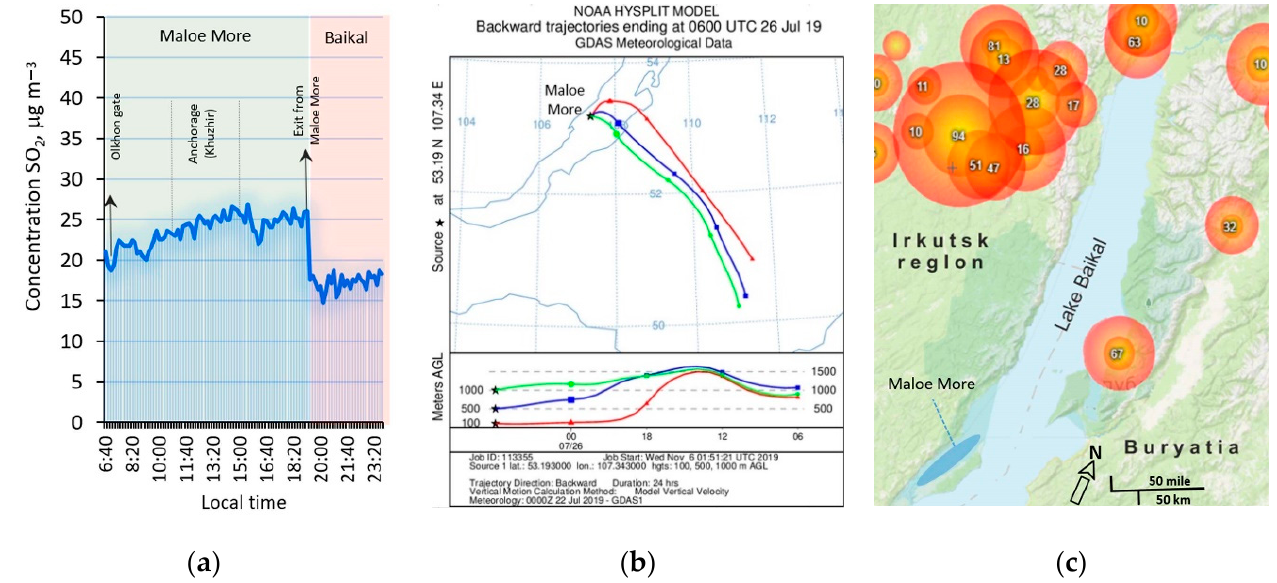
Figure 6. Temporal variation of the concentration of sulfur dioxide in the water layer of Lake Baikal during of 26 July 2019 ( a ); backwards trajectories of air masses according to the HYSPLIT model ( b ); the paths for the transfer of air masses trajectory at three altitude levels: 100 m (red color), 500 m (blue color) and 1000 m (green color); map of fires in the northern part of Lake Baikal for this period ( c ). The number of fires is indicated in the center of the circle.